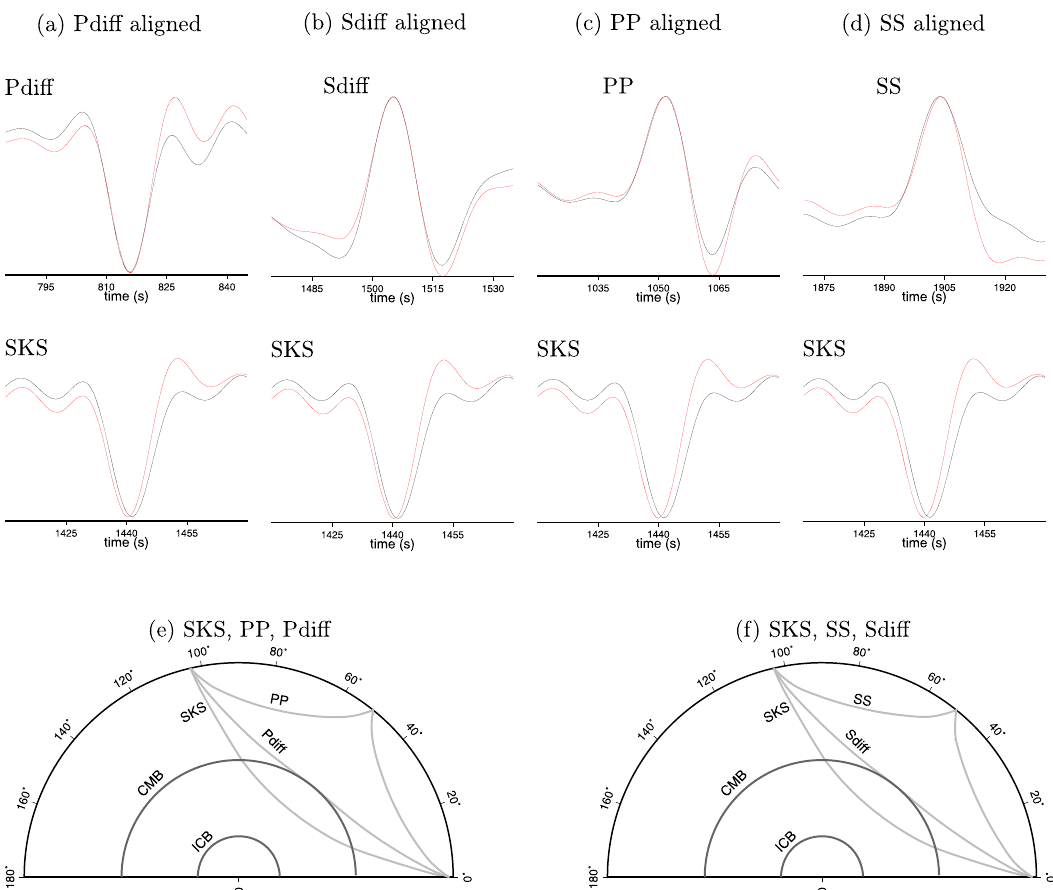
Fig. 1 Faster SKS wave from the second earthquake when reference waves are aligned. a – d Displacement seismograms were recorded at station COLA for two earthquakes with close hypocenter locations, the fi rst earthquake (black) occurred in 1997 and the second earthquake (red) occurred in 2018. The epicentral distance is ~99.4 ∘ . The SKS wave in 2018 is about 1 s faster when the reference phases Pdiff, Sdiff, PP, or SS are aligned. The relative advance times are 1.1, 1.05, 1.5, and 1.35 seconds, respectively. The magnitudes and moment tensors of the two earthquakes are different and the amplitudes of the seismograms in 2018 have been multiplied by a constant factor for easier visual comparison only. Travel time measurements are made on the original seismograms. The cross-section view of the ray paths of the SKS, Pdiff, Sdiff, PP, and SS waves are plotted in ( e ) and ( f ) for